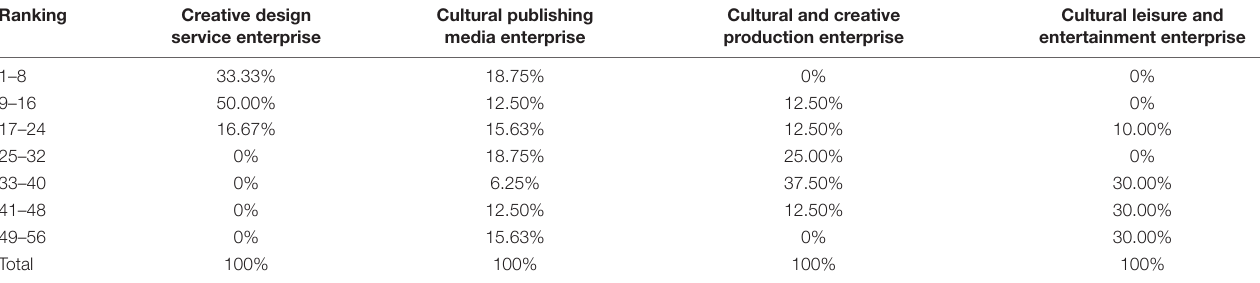
TABLE 9 | Distribution of enterprises in the four major